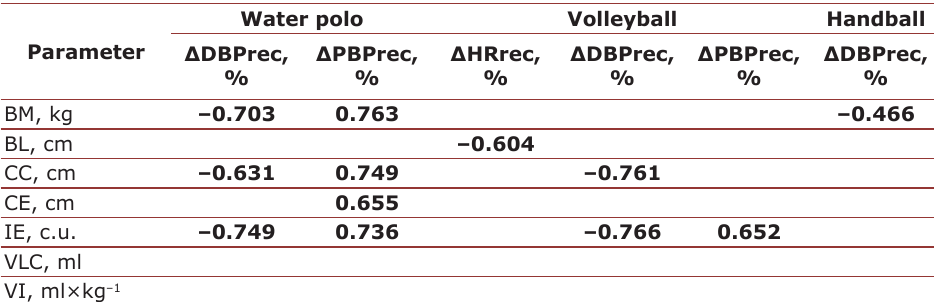
Table 5. Significant (p<0.05) correlations of indicators of the cardiovascular system recovery with indi - cators of athletes physical